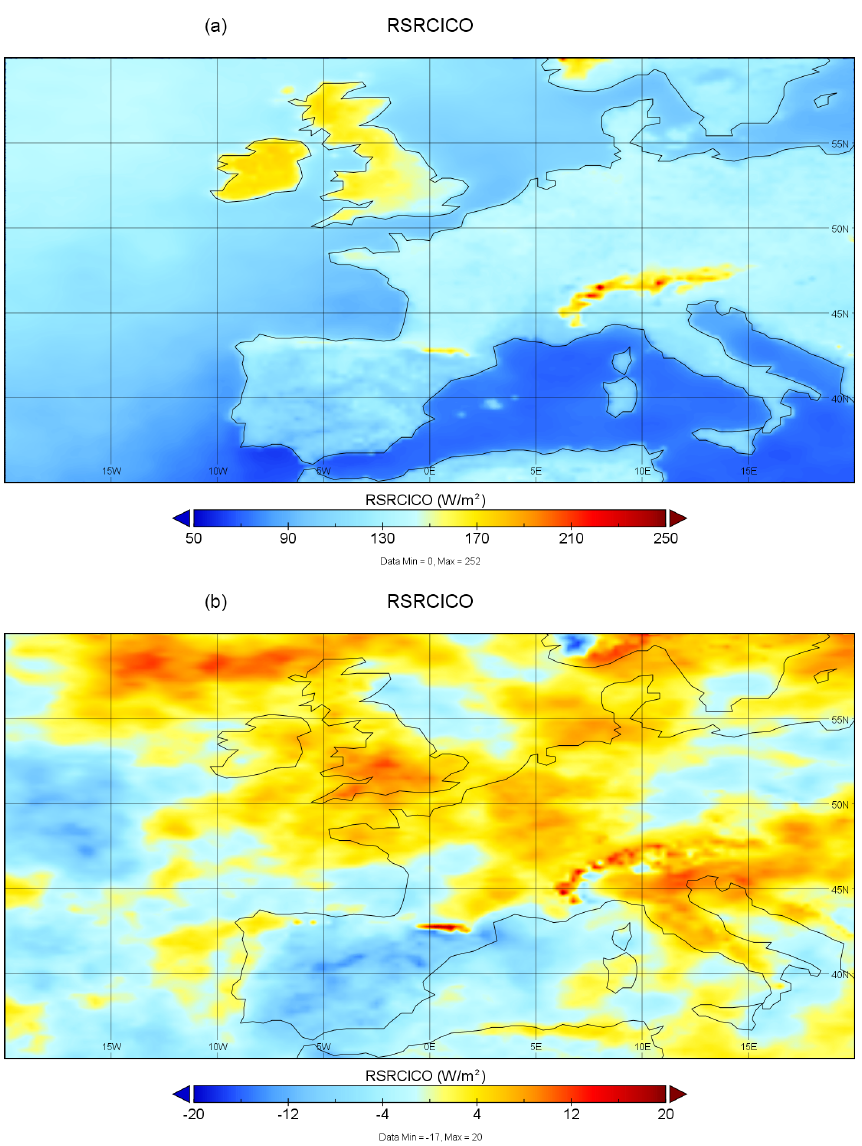
Figure 12. Mean reflected solar radiation (RSR) in Wm − 2 in the sum of IFS and CoCiP results from March–August in 2019 (a) and the 2019–2020 difference (b)